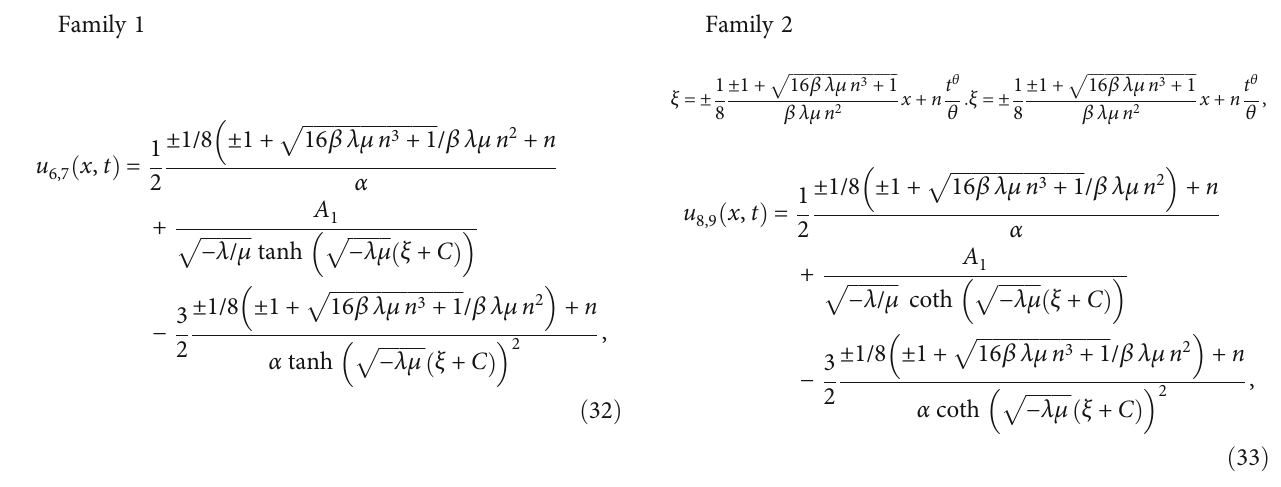
Figure 10: Dynamical behavior of function solution of u